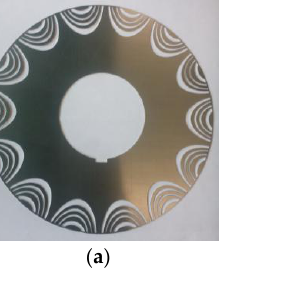
Figure 5. ( a ) Prototype rotor lamination; ( b ) Prototype rotor.